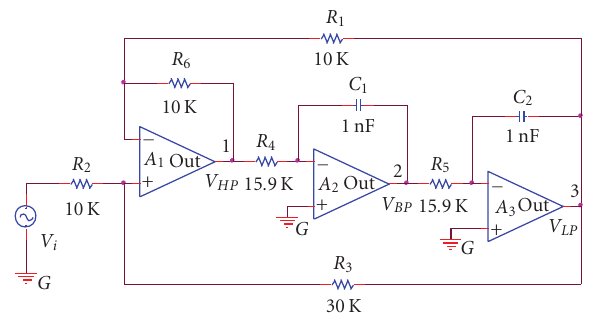
Figure 9: State variable filter